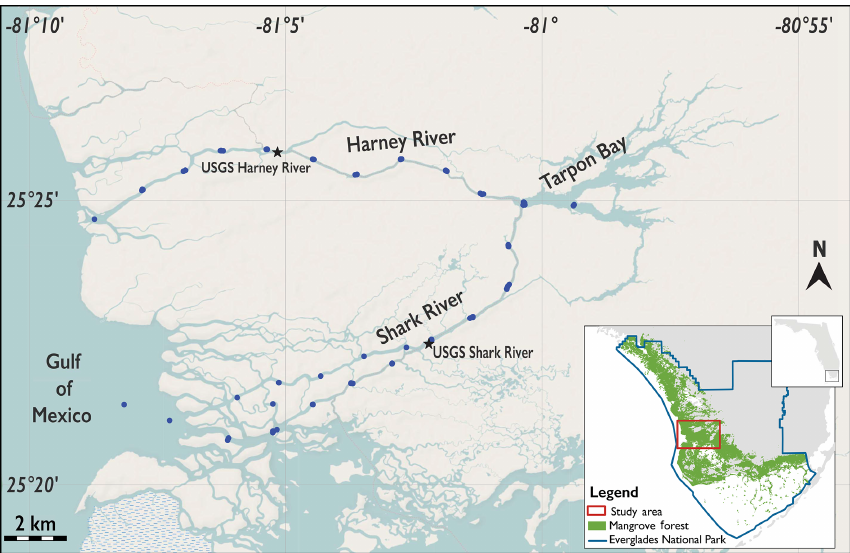
Figure 1. Map of the study area near the southern tip of Florida, USA, showing locations of Shark River, Harney River, and Tarpon Bay. The blue circles indicate the locations where discrete samples were taken, and the black stars denote the USGS gaging stations on both rivers. The green areas in the inset are part of the largest contiguous mangrove forest in North America. Indicated in the inset are the boundaries of Everglades National